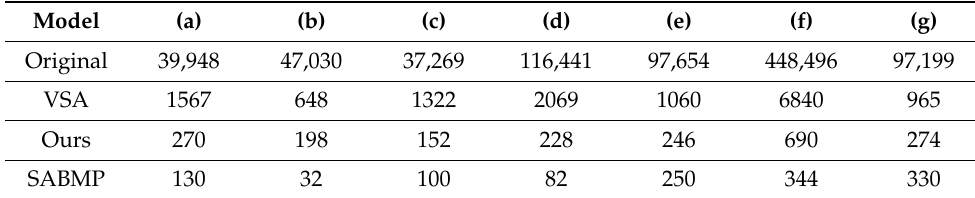
Table 1. Comparison of the number of model